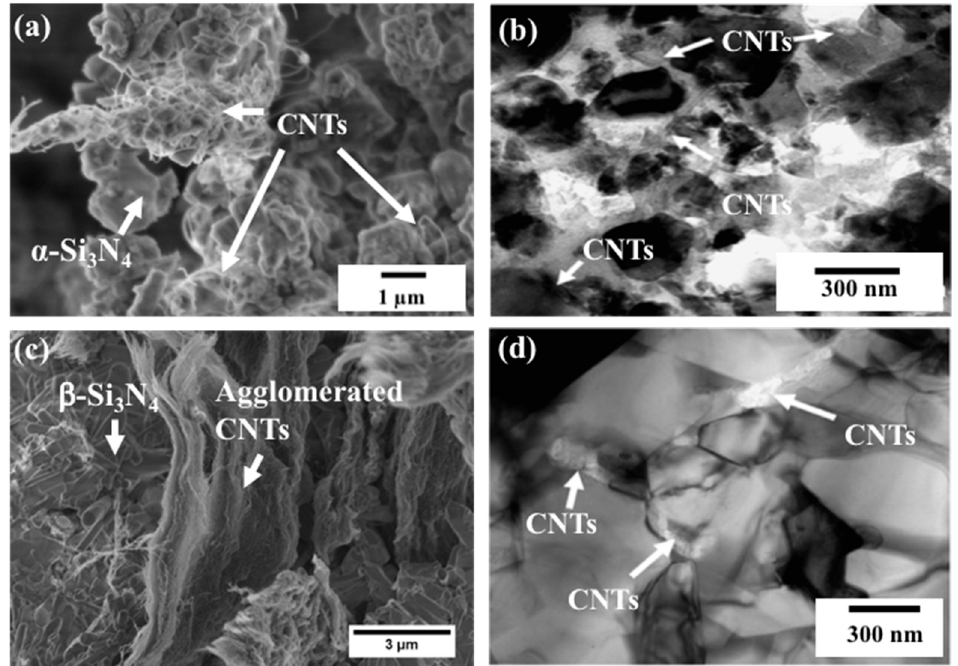
Figure 5. SEM and TEM images of CNTs dispersed in silicon nitride in powders and sintered silicon nitride: ( a ) the network of multi-walled carbon nanotubes (MWCNTs) around the α -Si 3 N 4 particles (3 wt.% MWCNTs + α -Si 3 N 4 starting powder with sintering additives Al 2 O 3 , Y 2 O 3 and PEG); ( b ) bright field TEM images of starting powder α -Si 3 N 4 with 3 wt.% CNTs prepared by attrition milling, arrows indicate the presence of CNTs between α -Si 3 N 4 grains [45]; ( c ) in the SEM image, MWCNTs are located in β -Si 3 N 4 grains of 3 wt.% MWCNTs + Si 3 N 4 composites. ( d ) Cross-section bright field TEM image shows the CNTs located in porosities and intergranular locations of β -Si 3 N 4 grains [45]. (Figure 5b–d) Reproduced from Refs. [45] with permission from Elsevier.